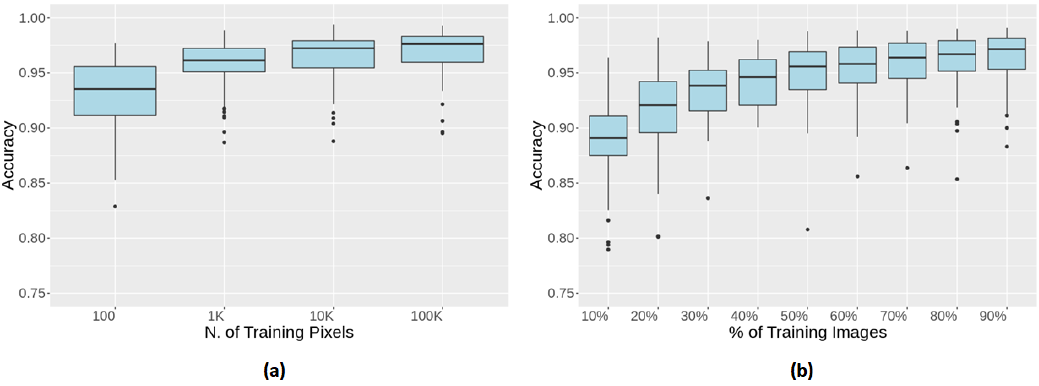
Figure 3. ( a ) Accuracy of the SVM classifier increases with the number of training examples: after 10 4 pixels are provided no significant improvement is registered. ( b ) The effect of heterogeneity on performance: despite the equal number of training examples (10 4 ), only after 50% of images are used, the performance reaches stable